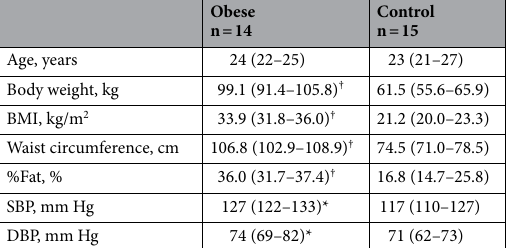
Table 1. Baseline characteristics of the obese and lean control groups of university students. Values are median (IQR) or n (%). BMI body mass index, DBP diastolic blood pressure, SBP systolic blood pressure. * P < 0.05 and † P < 0.01 vs.